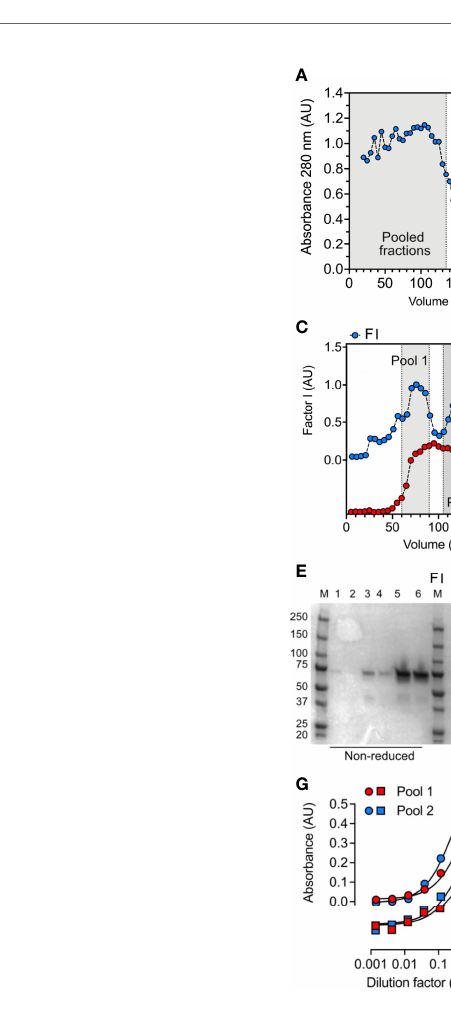
FIGURE 4 | Hemopexin co-puri fi es with factor I. For the puri fi cation of factor I (FI), human plasma was, after PEG precipitation, centrifuged at 13 000 x g for 30 minutes, and the supernatant was applied for sequential chromatography. (A – D) Chromatograms for (A) Sepharose FF, (B) lectin agarose, and (C, D) Mono Q columns. (A – C) Fractions were analyzed by direct ELISA by coating fractions in microtiter plate wells and analyzing for factor I (FI, blue) and hemopexin (only the Mono Q column) (Hx, red) content using speci fi c polyclonal antibodies. (D) Total protein in fractions from the Mono Q column was evaluated by absorbance measurements at 280 nm (absorbance units, AU). (A, B) Fractions within the gray area were pooled and applied for the next column. (C, D) The elution fractions from the Mono Q column (C, D) were pooled in two different pools: 1 (light grey) and 2 (dark grey) according to the two elution peaks for factor I (E, F) Western blot for factor I (E) and hemopexin (F) under non-reduced and reduced conditions. The following samples (10 m g) were analyzed: hemopexin puri fi ed from human serum (1), recombinant hemopexin (2), factor I “ pool 2 ” (3), factor I “ pool 1 ” (4), puri fi ed factor I bought from Quidel (5), puri fi ed factor I bought from CompTech (6). M corresponds to molecular weight marker. (G) Sandwich ELISA with pool 1 (red) and pool 2 (blue) incubated in threefold dilutions on microtiter plates coated with anti- FI (circles) and anti-hemopexin (squares) and detected with anti-hemopexin (circles) and anti-FI (squares). (H) SDS-PAGE for the degradation of C3b with different factor I-preparations (as indicated below the gel), incubated for 60 minutes at 37°C. All samples contain C3b, samples 2-6 contains factor H, and samples 2-5 contain factor I: pool 1 (P1) (2), pool 2 (P2) (3), CompTech factor I (C) (4), and Quidel factor I (Q) (5). The intact alpha´- and beta chain of C3b are indicated by a ´ and b ,